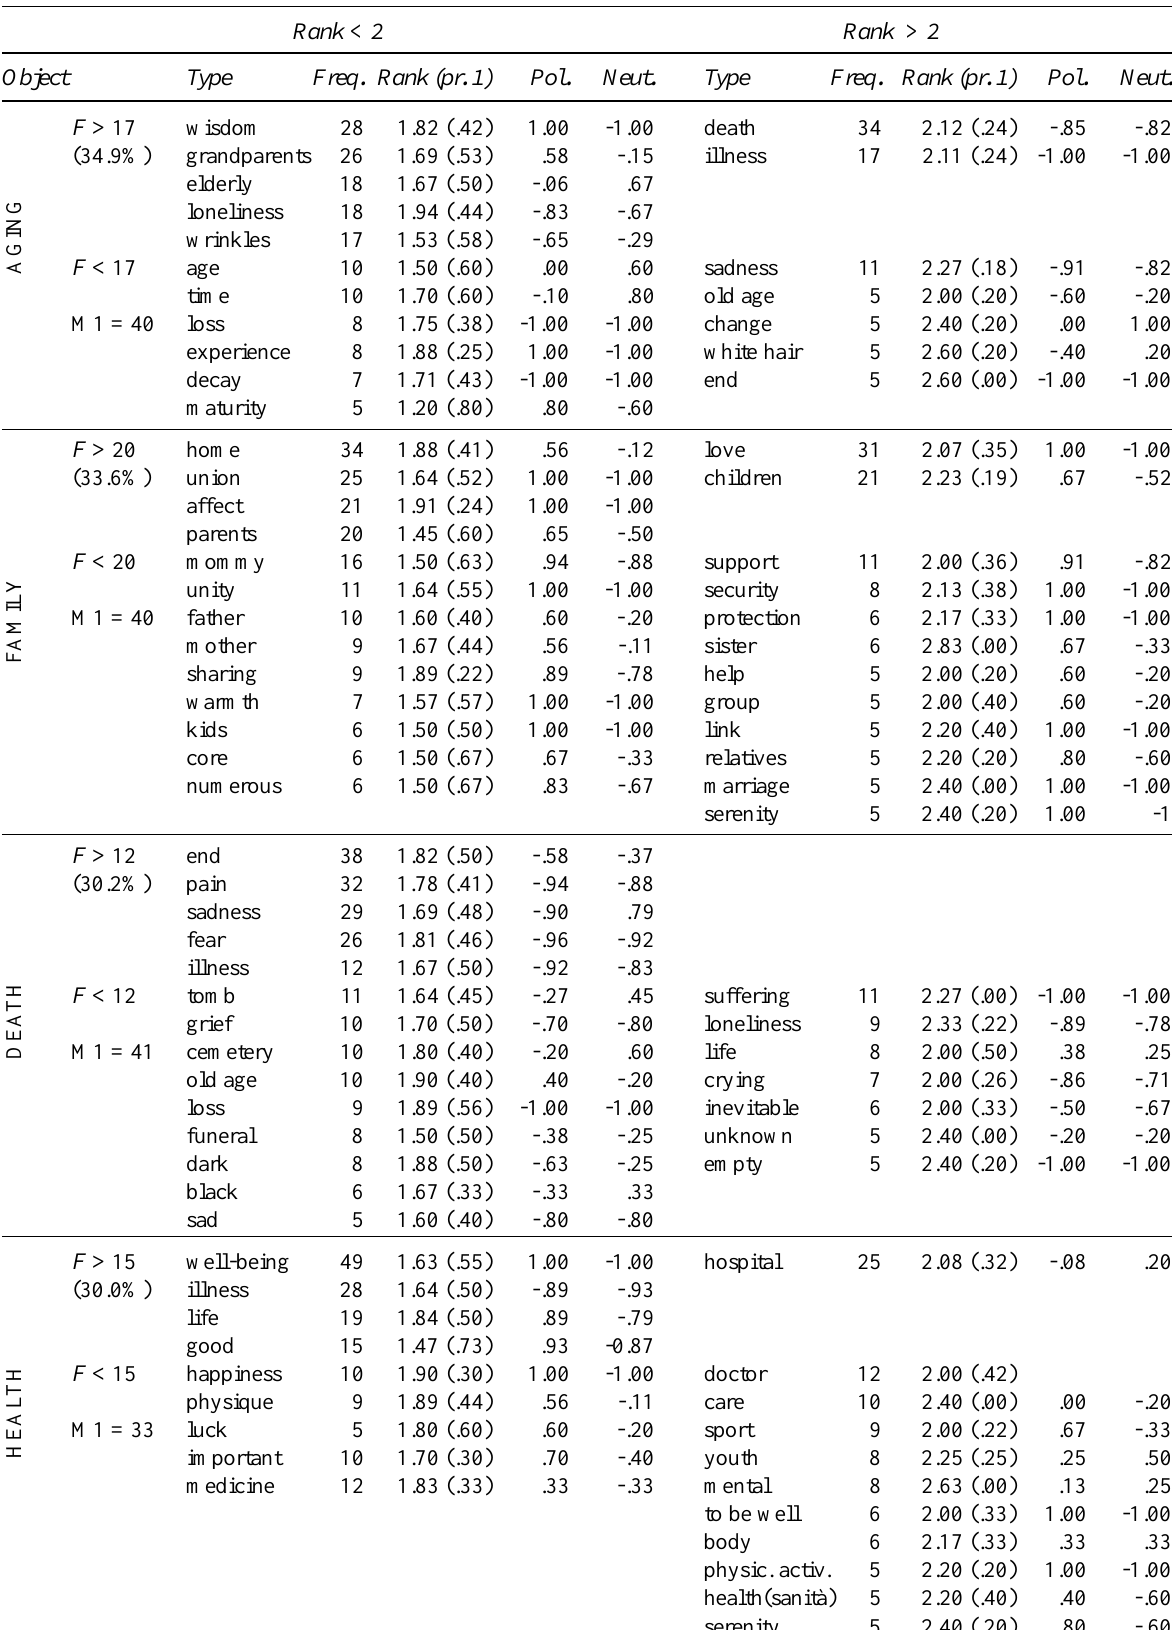
Prototypical Analyses for the Four Retained Social Objects Rank < 2 Rank > 2 Object Type Freq. Rank (pr. 1) Pol. Neut. Type Freq. Rank (pr. 1) Pol.